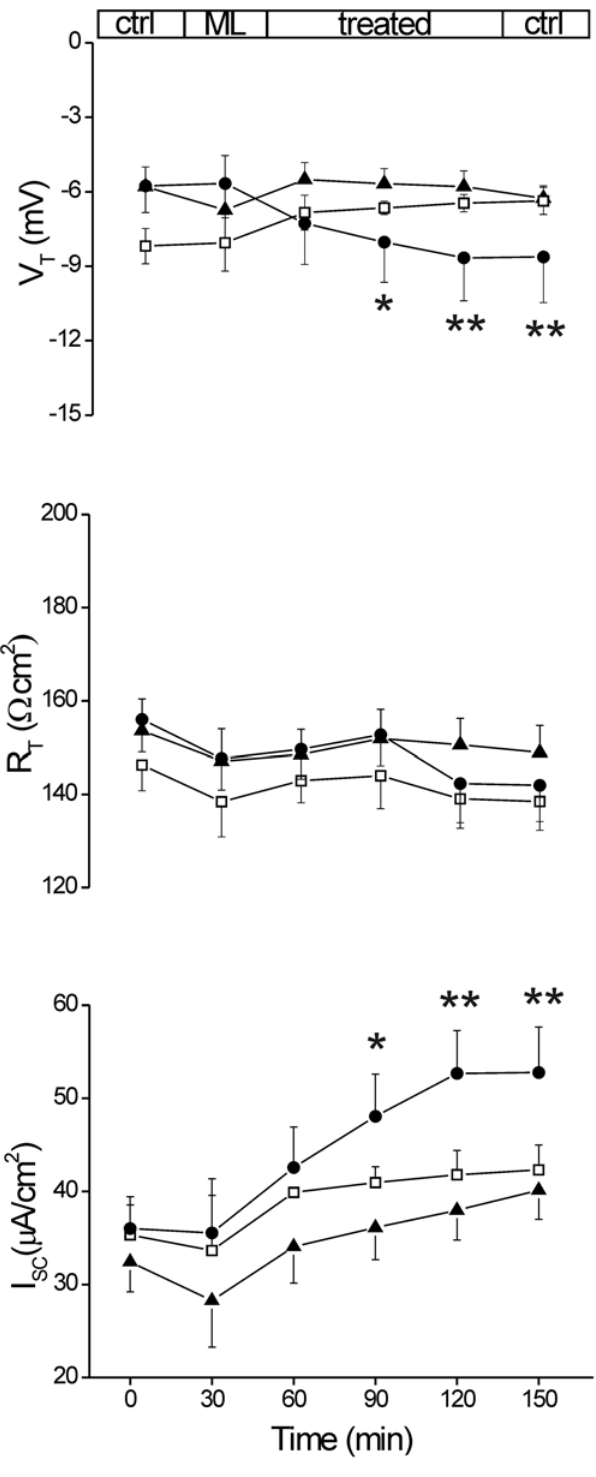
Figure 4. Effect of mucosal exposure to Staphylococcus aureus a -hemolysin. Human sigmoid colon specimens in the basal state (Ctrl) and during mucosal incubation (Treated) with a -hemolysin 60 nM (filled triangles: n=5; m=4), 90 nM (empty squares: n=3; m=3) and 120 nM (filled circles: n=6; m=6). Electrical parameters were measured as reported in legend of Fig. 3. Each data point represents the average 6 S.E.M. of measurements in n specimen from m mucosae. Significance was determined by Student’s t test for paired data of treated vs control (time=0); *, p , 0.05; **, p , 0.02. doi:10.1371/journal.pone.0005074.g004 PLoS ONE |